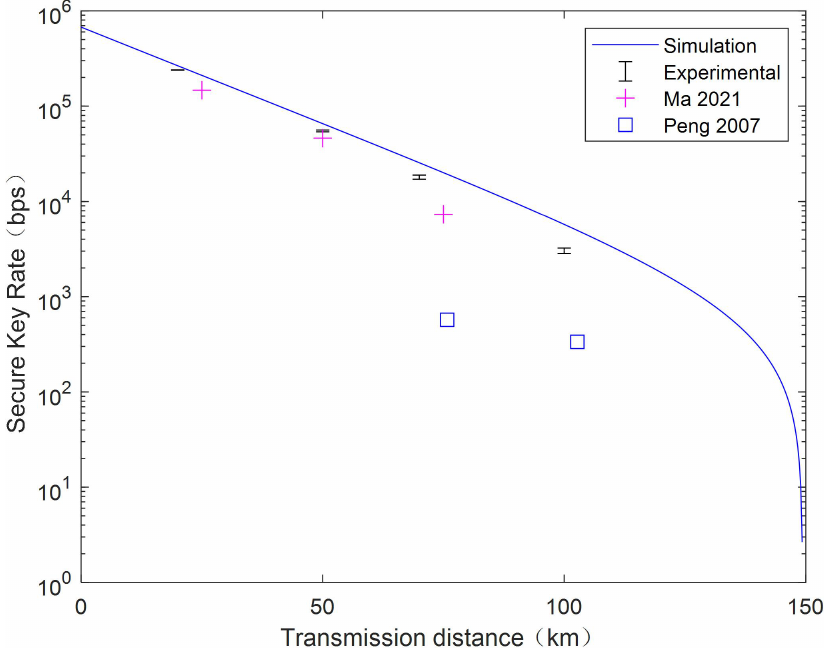
Figure 3. The key rate performance of SCPE. The experimental rate distance performance of SCPE, compared with the theoretical simulations, along with Peng [35] and Ma